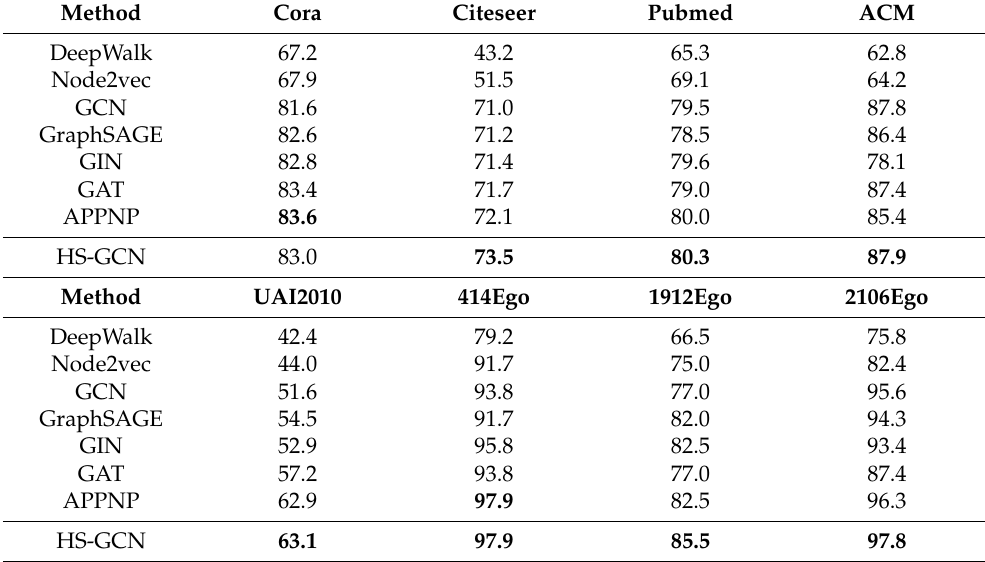
Table 2. The results (max %) of node classification for baseline methods and our method. (Bold: best performance for each